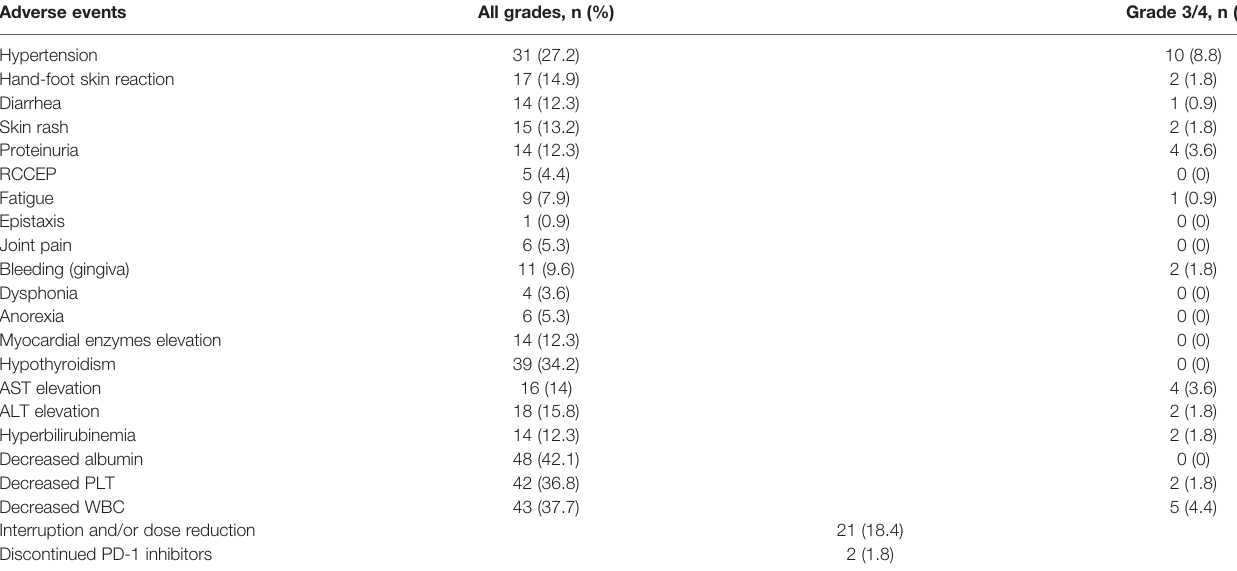
TABLE 3 | Treatment-related adverse